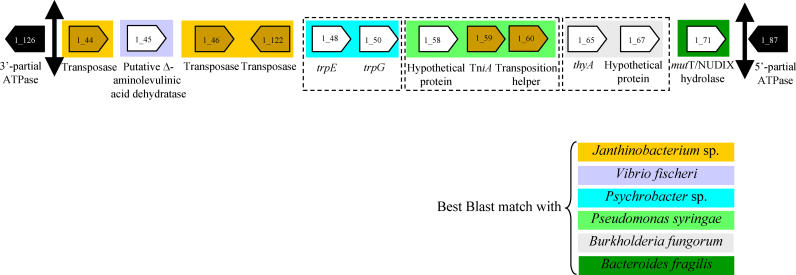
Layout of the Complete AbaG1 Inserted into the SDF Strain ATPase-Encoding GeneThe nomenclature of each ORF is indicated. Each ORF is identified according to EMBL entry CT025833. ORF categories are indicated by colors: transpositions in brown and other functions in white. The phylogenetic origin of genes is highlighted by color markers. Dashed lines indicate genes found in the same order in other bacteria.